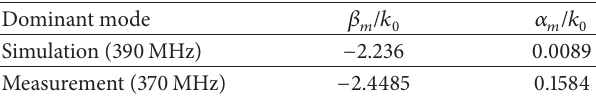
Table 1: Propagation parameters of the dominant